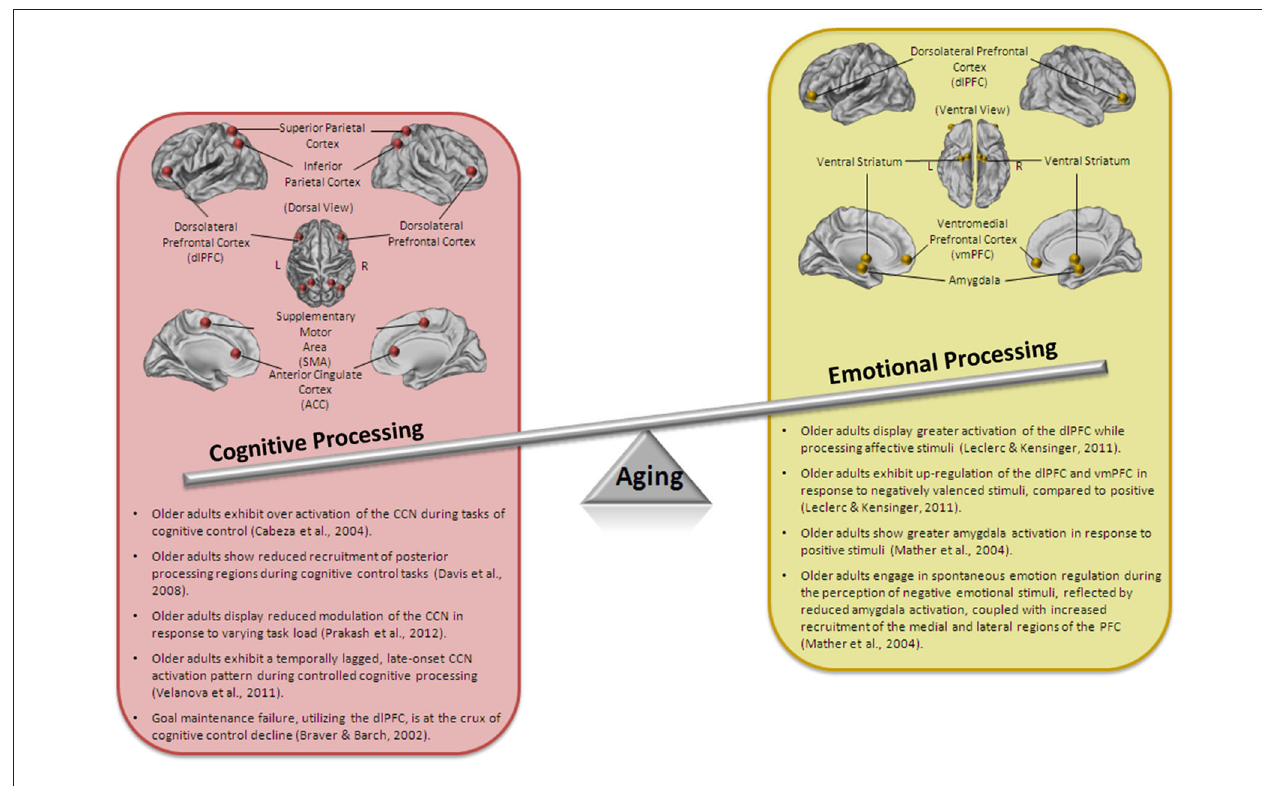
correlates of cognitive control. However, emotional processing, and at times, emotional regulation is well-maintained and even enhanced in older